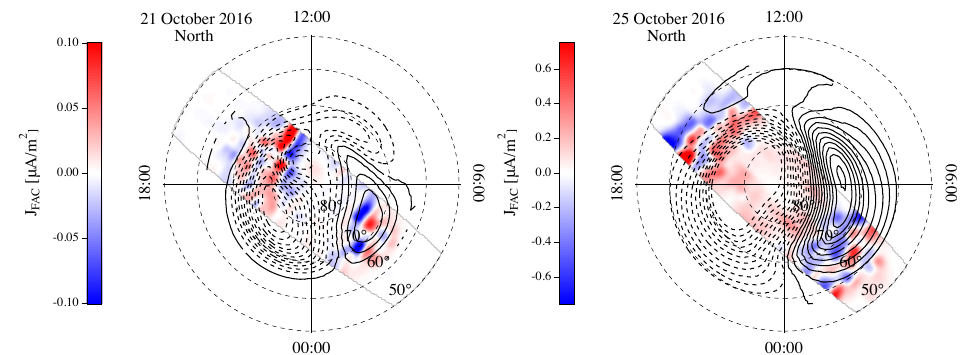
Figure 4. The average FAC patterns for the two selected days in the Northern Hemisphere in comparison with the CS10 electrostatic potential maps. Dashed and solid contours refer to negative and positive polar equipotential lines, respectively. The concentric circles indicate magnetic latitude contours with a separation of 10 ◦ from each